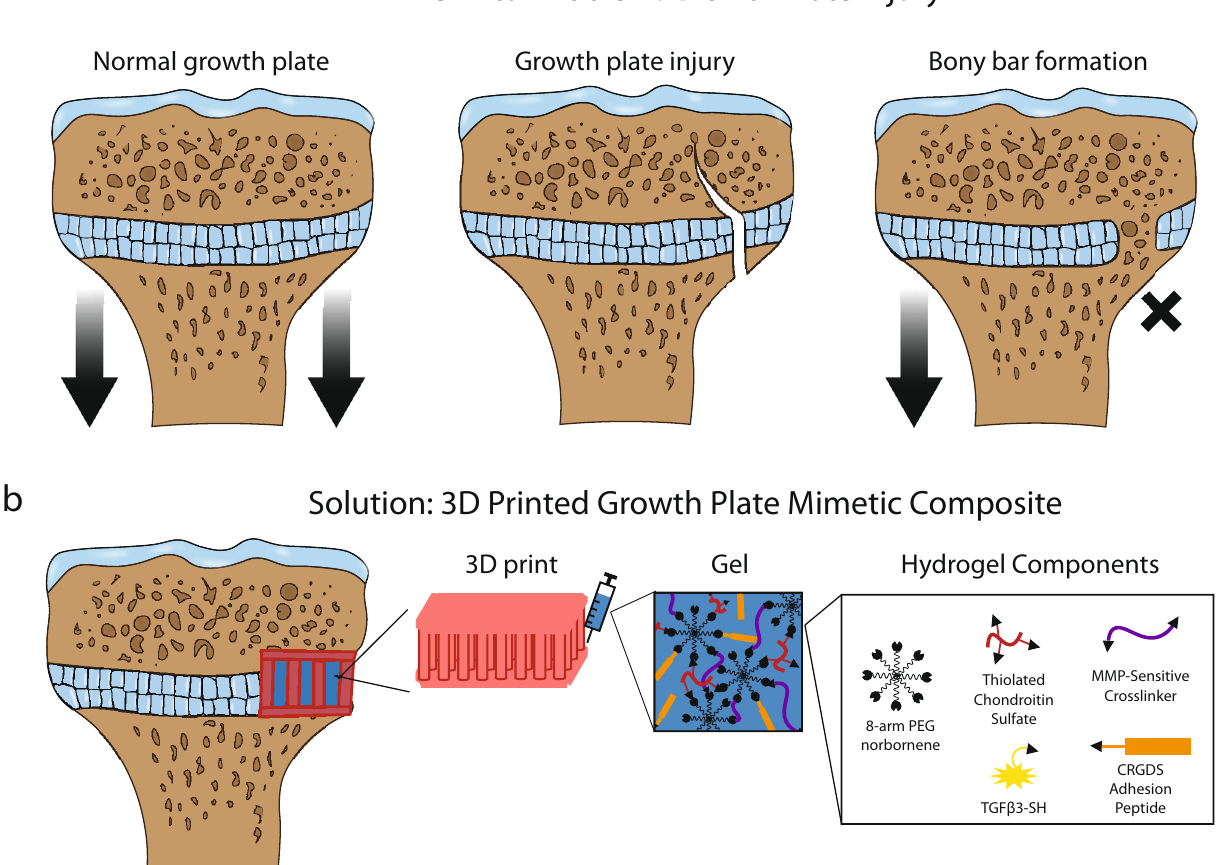
Fig. 1 Overview of the clinical problem of growth plate injury and the use of a 3D printed growth plate mimetic composite as a solution. a Schematic of uniform bone elongation in a normal proximal tibial growth plate (left), which can be disrupted by a growth plate injury (center), and lead to partial or complete growth arrest due to bony bar formation (right). b Schematic of the implanted 3D printed growth plate mimetic composite (gel + 3D print) after resection of the bony bar. The composite contains a 3D print in fi lled with the MMP-sensitive, cartilage-mimetic, PEG-based hydrogel (Gel). The hydrogel components are shown on the